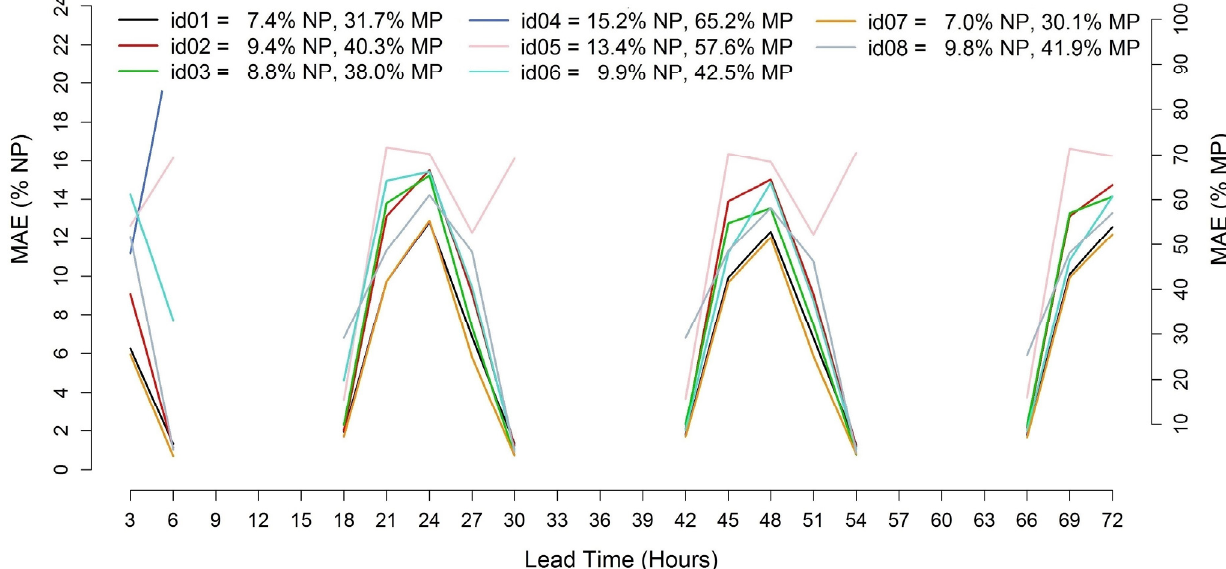
Figure 7. Error trends of the 3–72 h ahead solar power forecasts starting at 12 UTC for the Milano test case ( MAE / NP % and MAE /MP